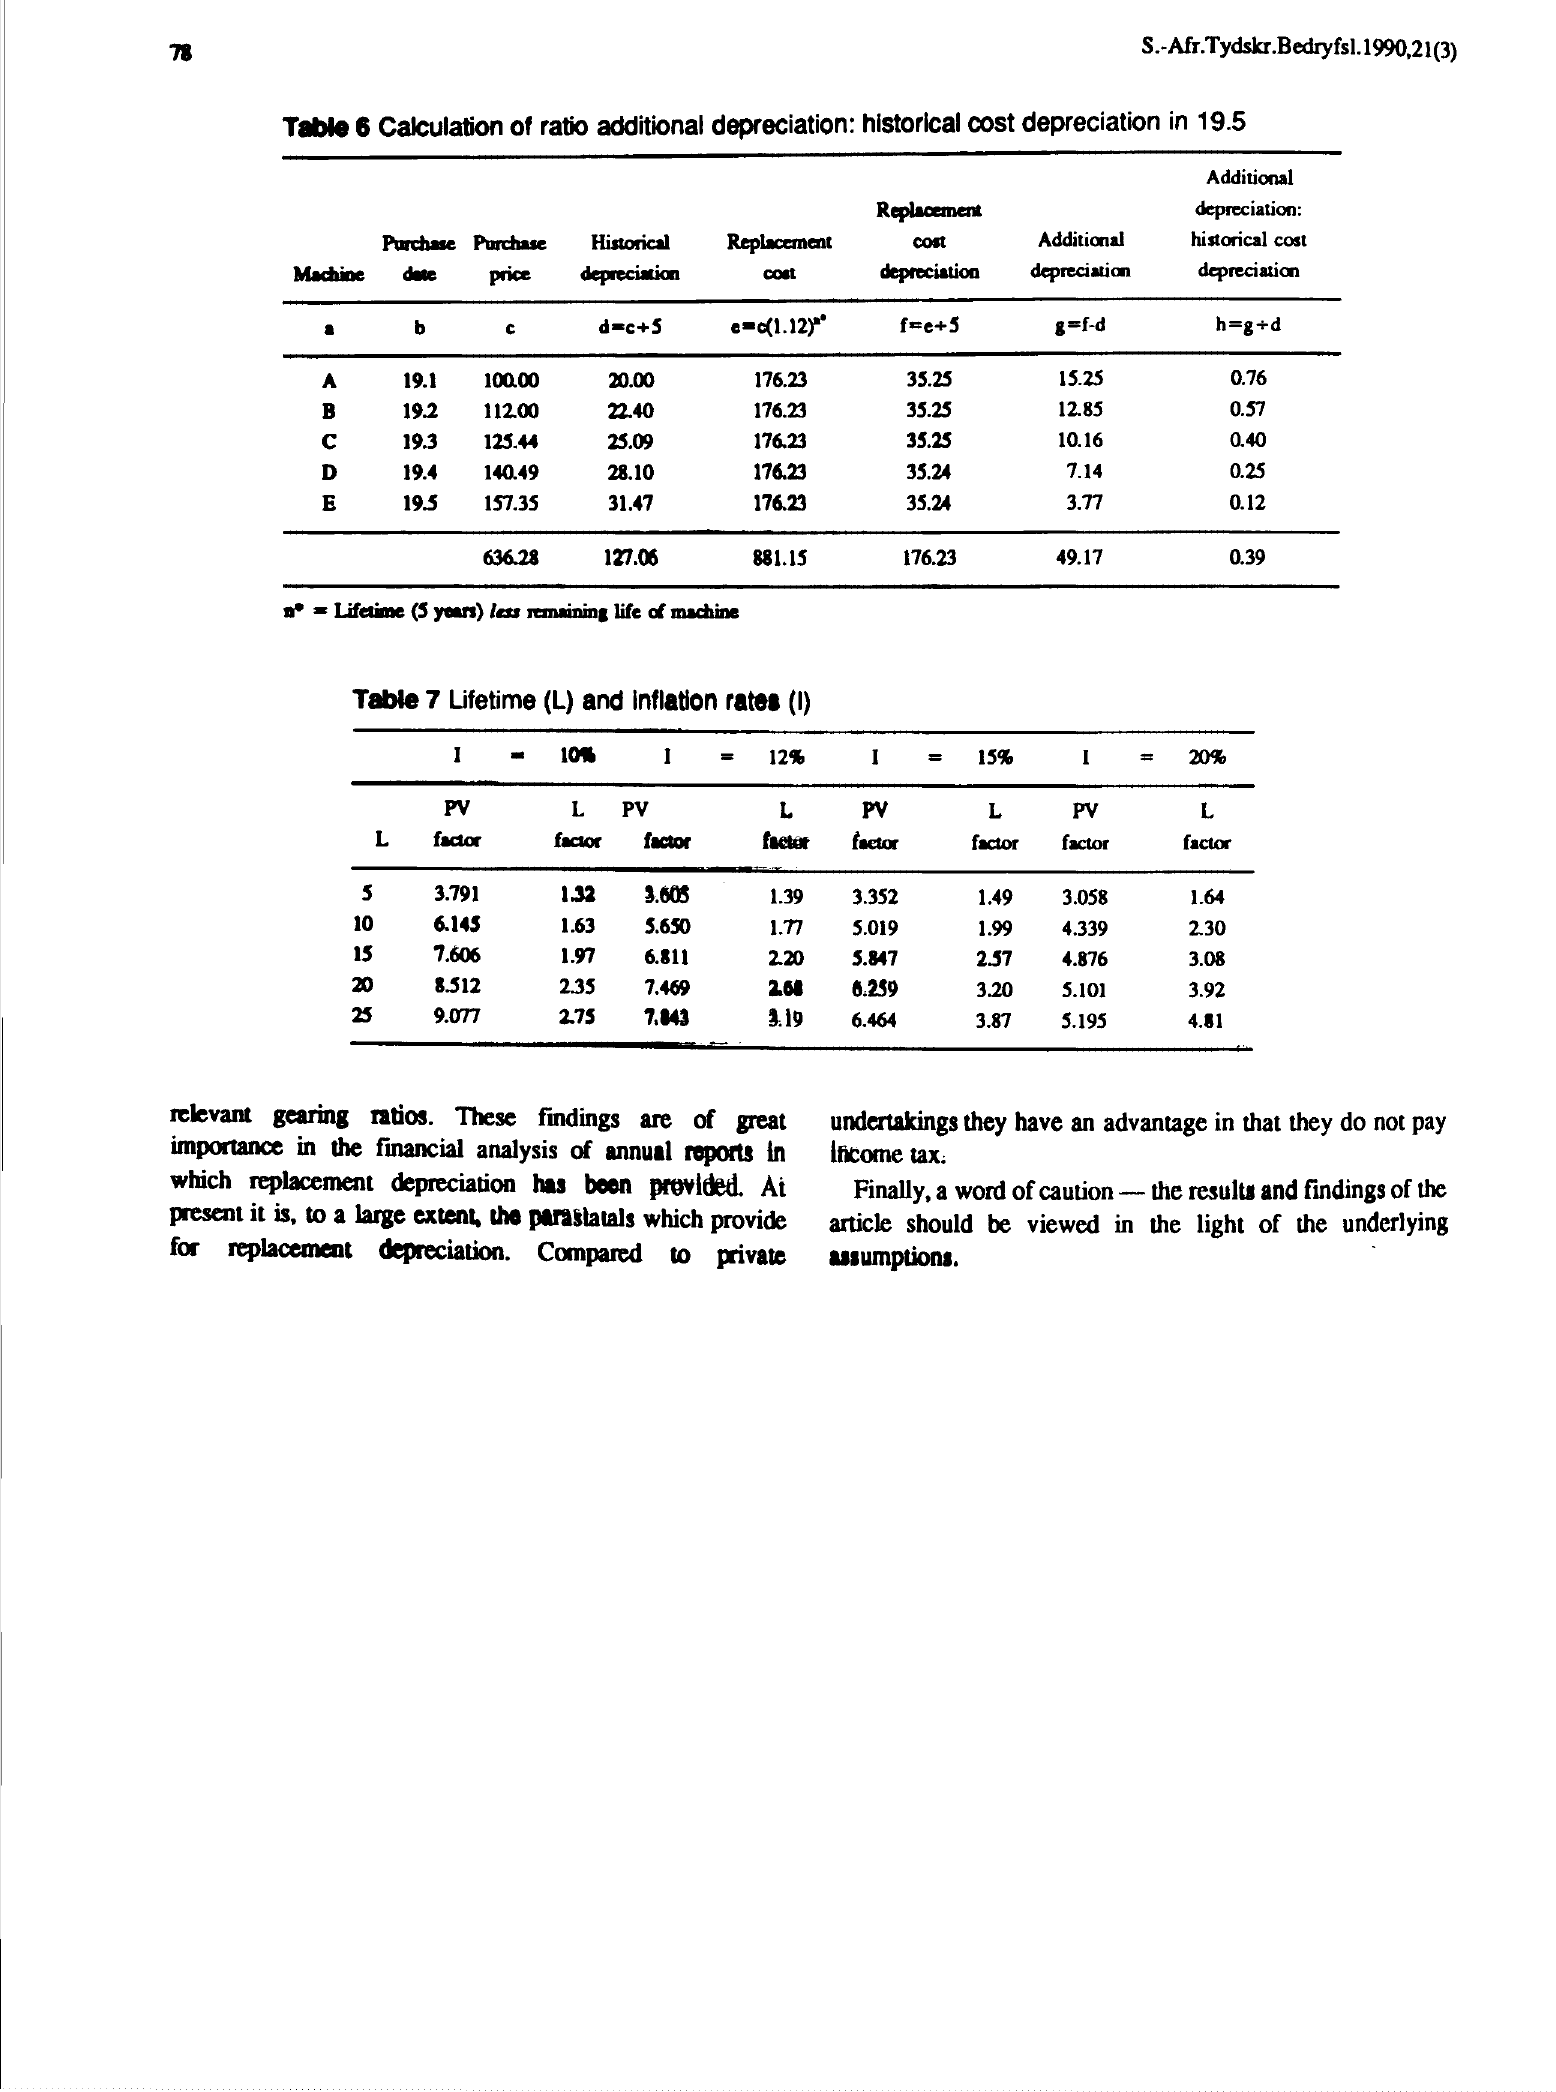
Table & Calculation of ratio additional depreciation: historical cost depreciation in 19.5 Additional Replacement depreciation: Purdme Purcbue HiSIOric:al Replacement Additional historical cost depreciation